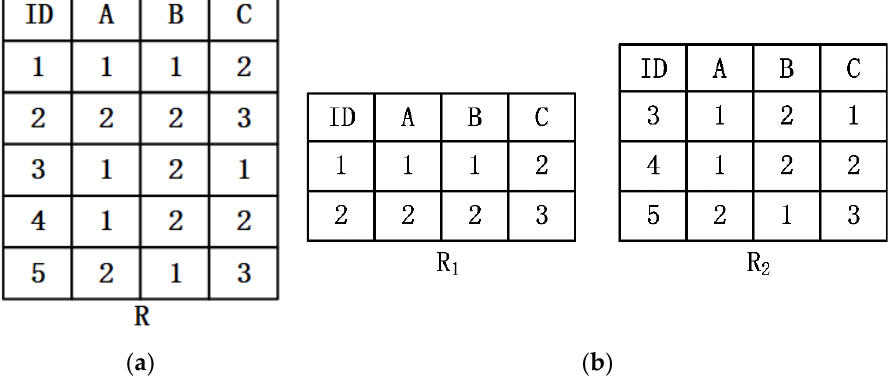
Figure 1. ( a ) Relation R ; ( b ) The horizontal segmentation R 1 and R 2 of R 𝑅𝑅 However, functional dependencies that pass local validation do not necessarily hold does not hold on . Therefore, the existing centralized functional dependency 𝐴𝐴 → 𝐵𝐵 𝑅𝑅